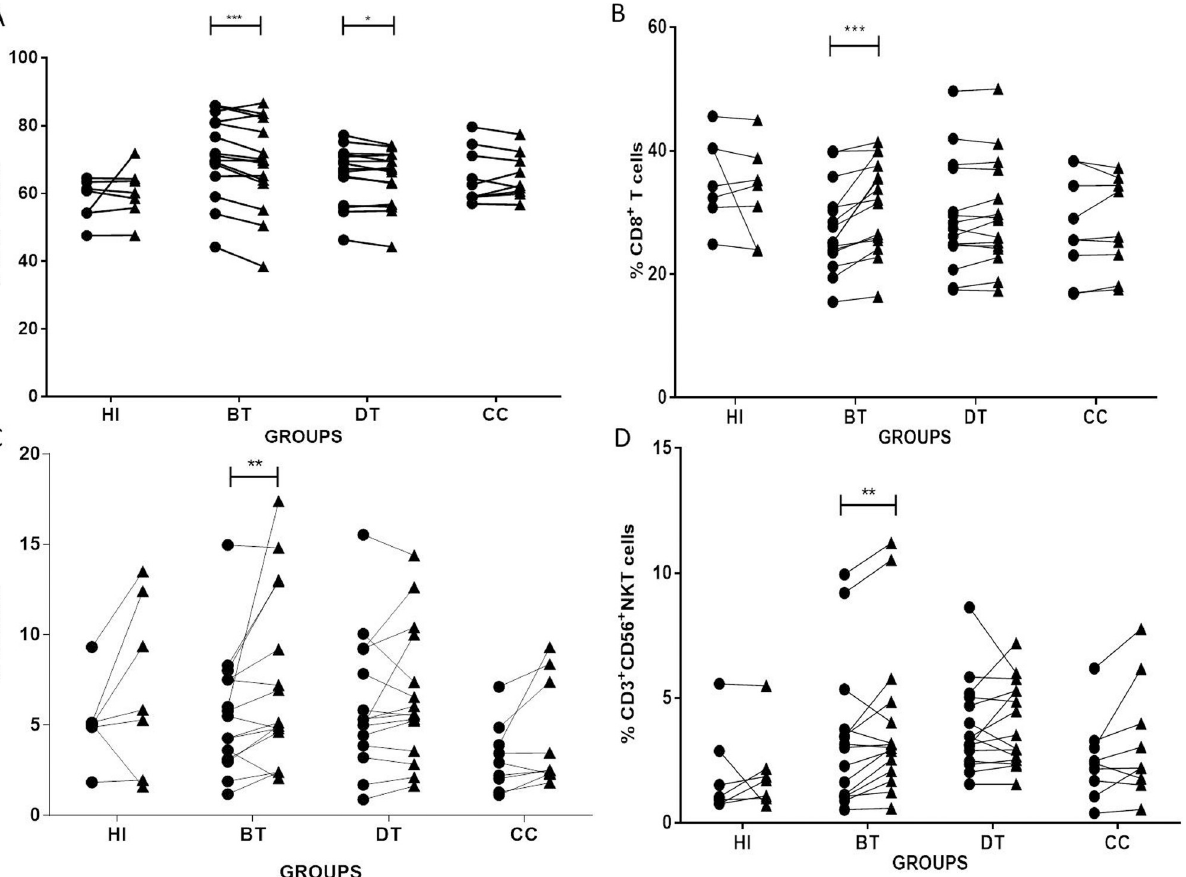
Fig 2. Analysis of CD4 + T, CD8 + T, NK and CD3 + CD56 + NKT cells in L . braziliensis -antigens-stimulated-cell cultures. Paired–analyses graphics show frequencies of ( A ) CD4 + T; ( B ) CD8 + T; ( C ) NK; and ( D ) CD3 + CD56 + NKT cells from before treatment (BT; n = 15); during treatment (DT; n = 15); clinical cure (CC; n = 9) patients. HI (n = 7) represents cell cultures from healthy individuals. Solid lines connect the results of non-stimulated (NS) ( ● ) and stimulated with L . braziliensis antigens ( Lb AgS) ( ▲ ) cell cultures for the same individual. Statistical analyses were performed by nonparametric Wilcoxon matched pairs test. Results between NS ( ● ) and Lb AgS ( ▲ ) cell cultures were considered significant with P � 0.05. � (P � 0.05); �� (P � 0.01); ��� (P � 0.001).